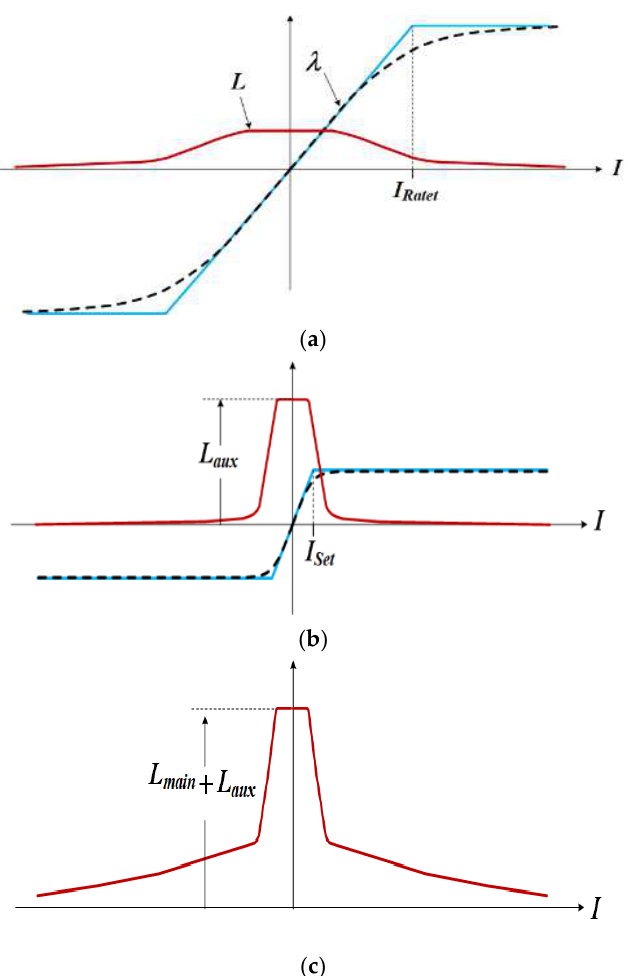
Figure 3. Characteristics of heterogeneous inductors as a function of current. ( a ) Reactor characteristics with large rated capacity; ( b ) Reactor characteristics with small rated capacity; ( c ) Hybrid Reactor Characteristics.